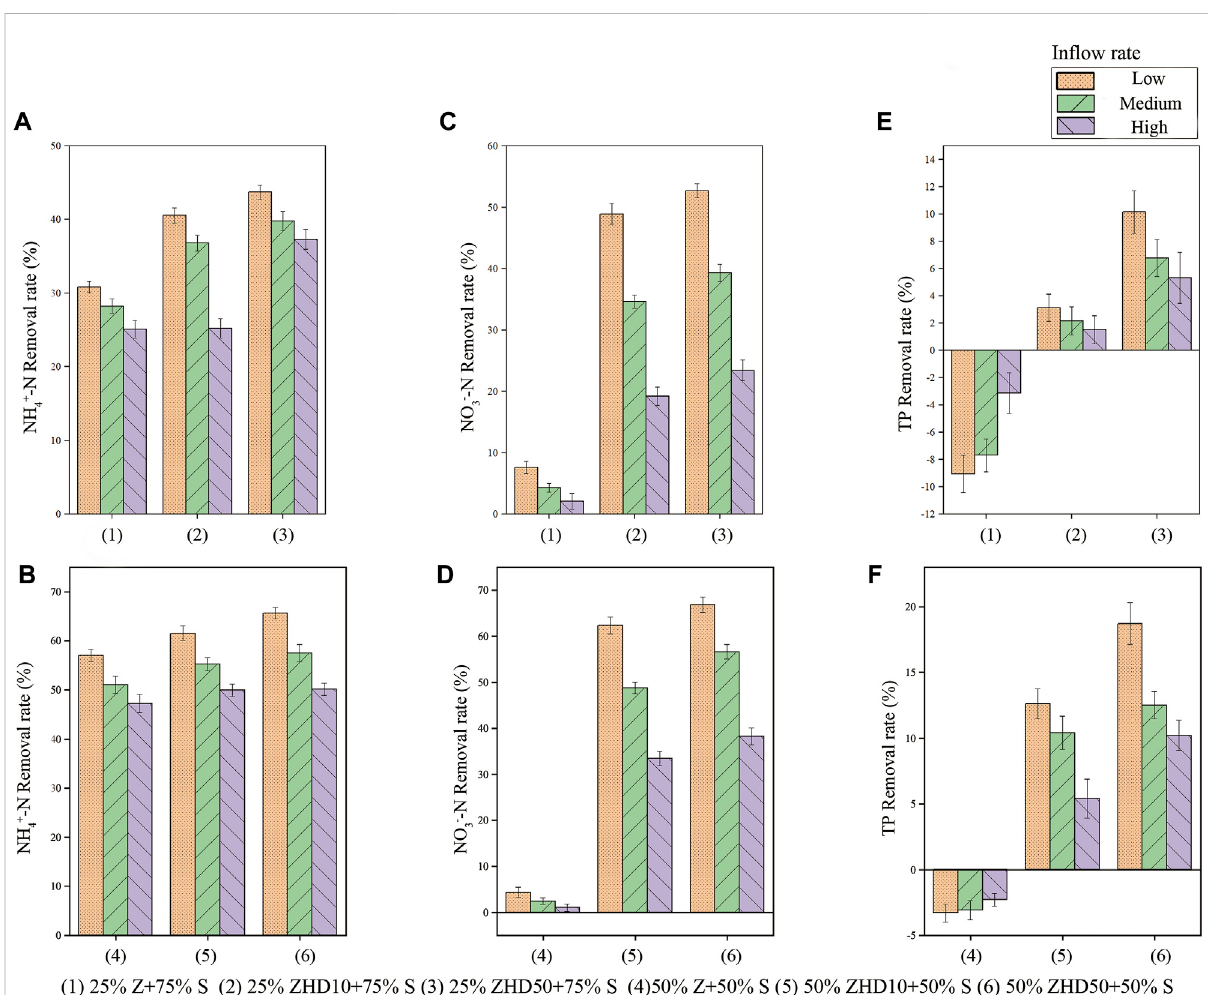
FIGURE 5 Removal rate of different media on different pollutants (A) NH 4 + -N removal rate of substrate with 25% zeolite, (B) NH 4 + -N removal rate of substrate with 50% zeolite, (C) NO 3 − -N removal rate of substrate with 25% zeolite, (D) NO 3 − -N removal rate of substrate with 50% zeolite, (E) TP removal rate of substrate with 25% zeolite, and (F) TP removal rate of substrate with 50%